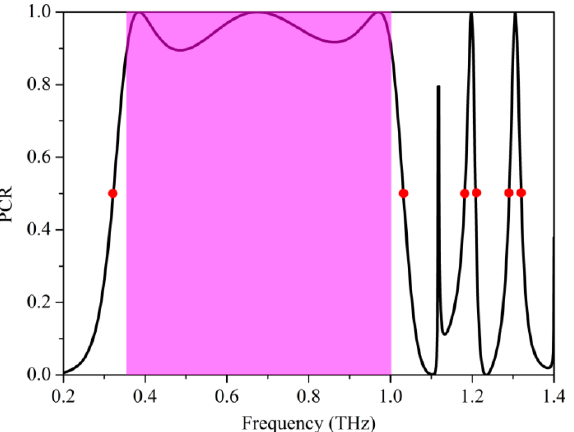
Figure 4. The polarization conversion efficiency of terahertz metasurface. The purple region indicates the PCR greater than 90%. The red dots denote the frequencies of 0.32 THz, 1.03 THz, 1.18 THz, 1.21 THz, 1.29 THz, and 1.32 THz, respectively.